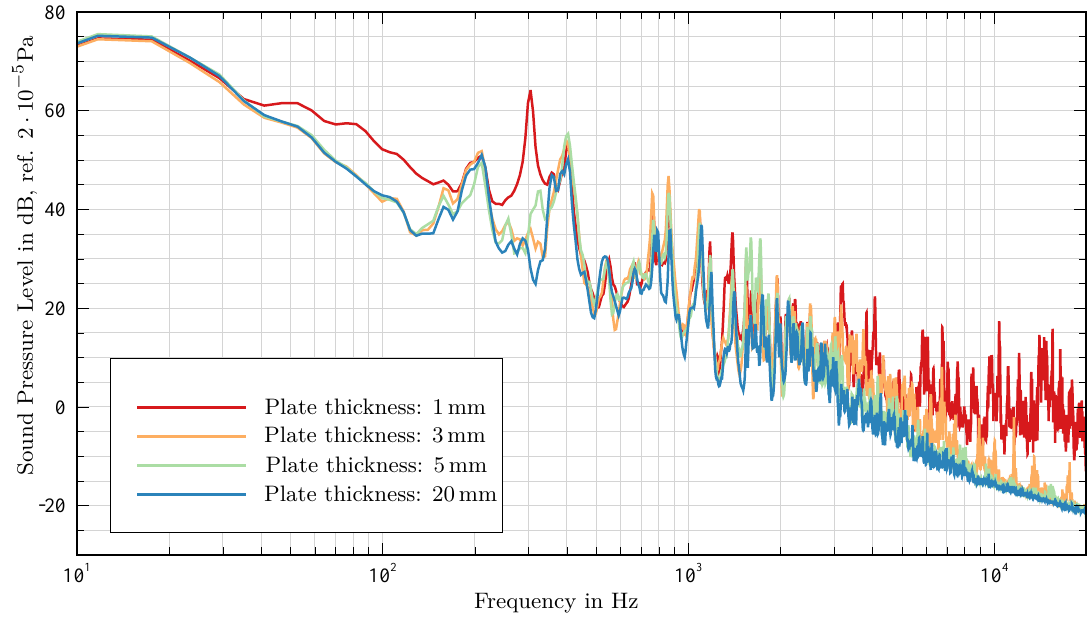
Figure 13. Sound Pressure Level at variation of the plate thickness.